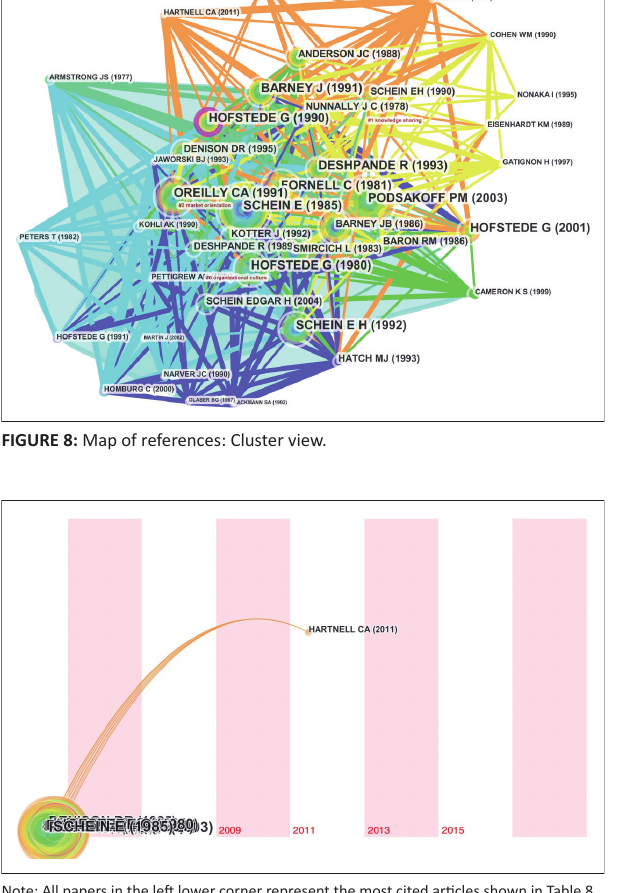
Note: All papers in the left lower corner represent the most cited articles shown in Table 8. FIGURE 9: Map of references: Timezone view.